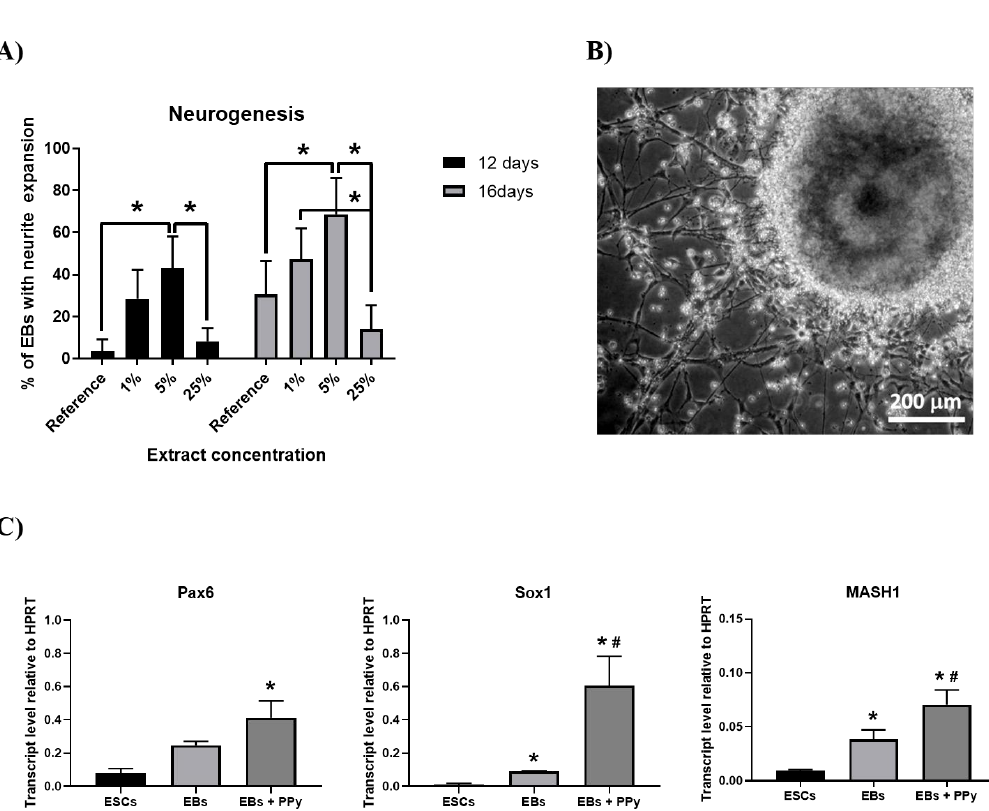
Figure 5. Influence of PPy extracts on neurogenesis. ( A ) Formation of EBs with neurite expansion after treatment with PPy extracts. ( B ) Microscopic visualization of expanded EB with neurites. ( C ) the expression of early neurogenic transcripts (Pax6, Sox1, and MASH1) in non-differentiating ESCs and in 5-day-old EBs growing in the absence (EBs) or in the presence of 5% PPy extract (EBs + PPy). Data are reported as the mean and standard deviations from a minimum of four independent experiments. Statistical significance was determined by ANOVA with post hoc Tukey’s Multiple Comparison test; * p < 0.05. (*) and (#) mark statistically significant differences compared to ESCs and to EBs without PPy treatment, respec- tively.